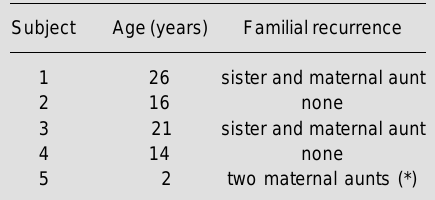
Table 1 - Age at diagnosis and familial recurrence status of the five CAIS patients. *One of the two maternal aunts of subject 5 was previously examined by